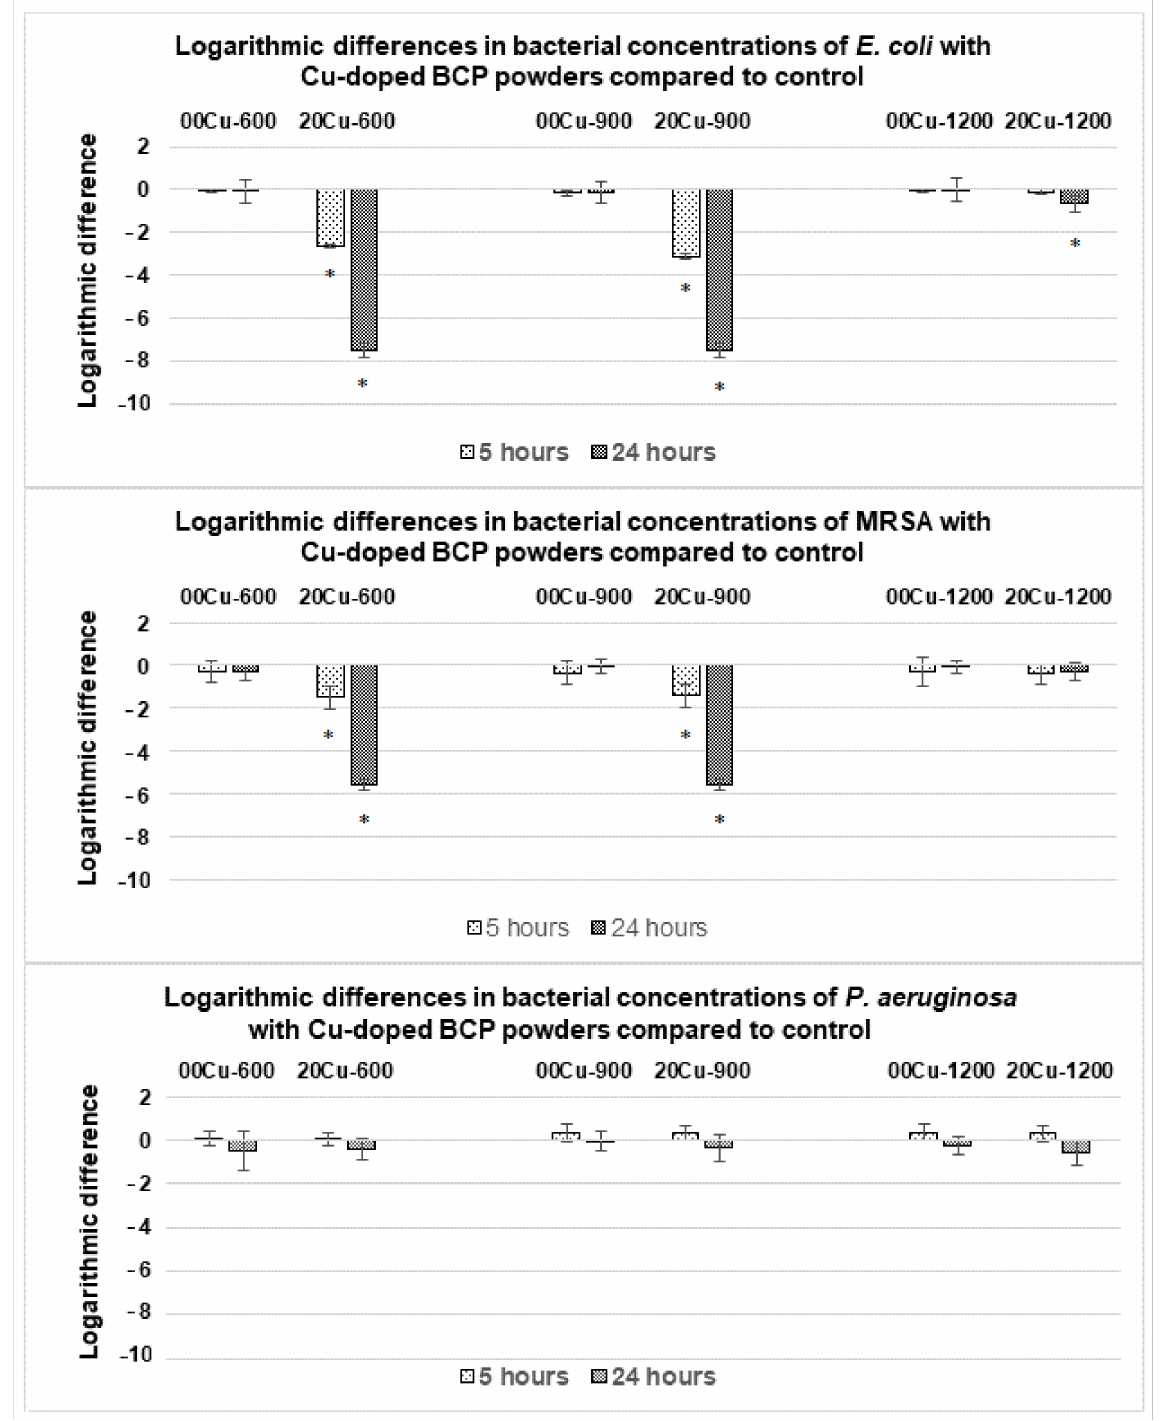
Figure 4. Logarithmic differences in bacterial concentrations of E. coli ( top ) , Methicillin-Resistant S. aureus (MRSA) ( middle ) and P. aeruginosa ( bottom ) with Cu-doped BCP powders compared to the control (undoped powders) after 5 h and 24 h. Results statistically different compared to the control (with p < 0.05) are indicated by